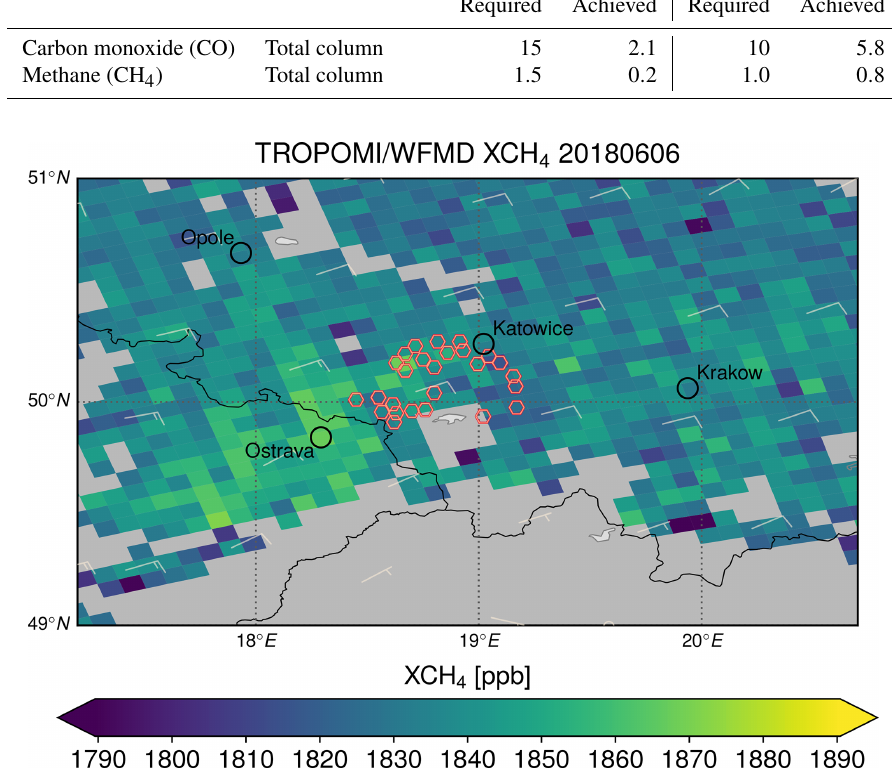
Figure 24. Methane distribution over the Upper Silesian Coal Basin in Poland. Individual mines are highlighted by red hexagons.